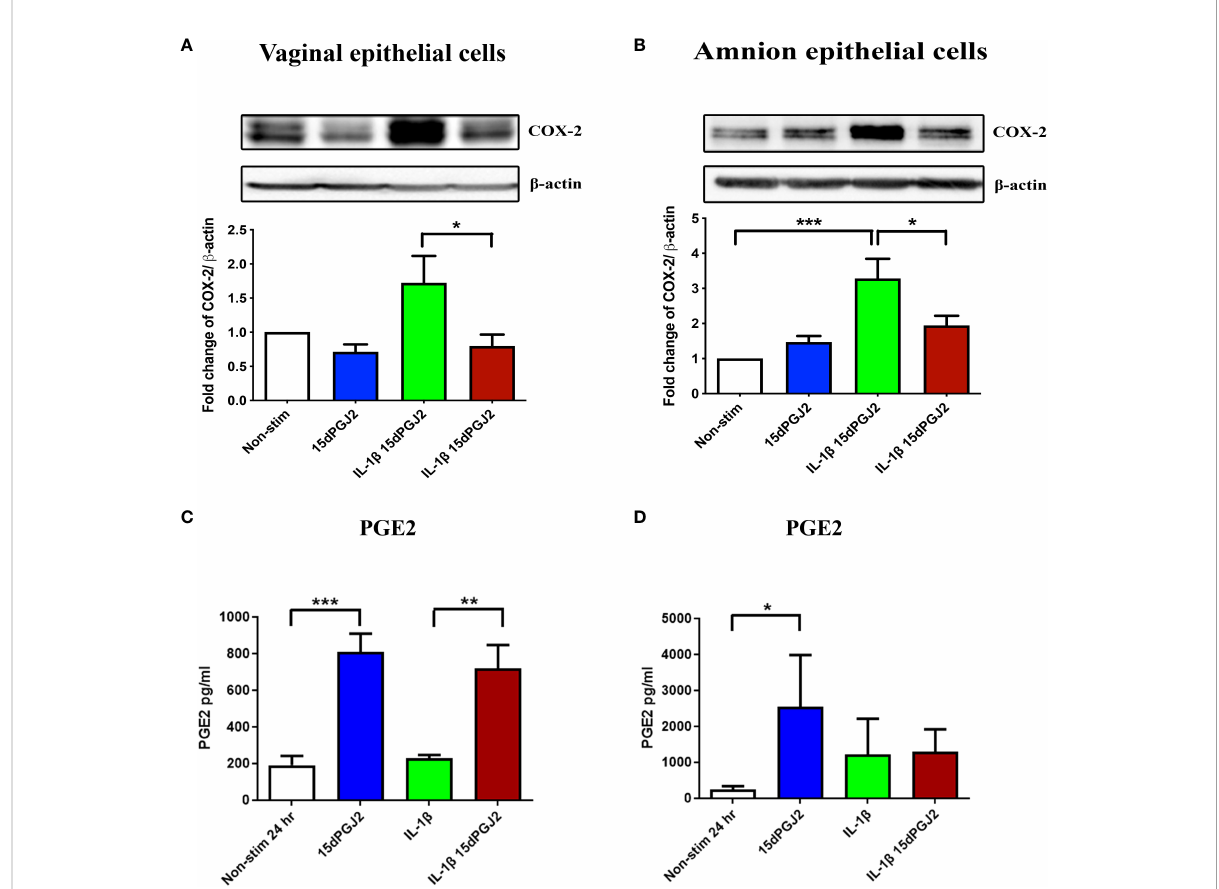
FIGURE 8 Effect of 15dPGJ2 on COX-2 and PGE2 in vaginal and amnion epithelial cells. VECs and AECs were pre-incubated with 32 m M of 15dPGJ2 for 2 hours then stimulated with 1ng/ml of IL-1 b for 4 hours to examine COX-2 protein expression and 24 hours to examine PGE2 production. Whole cell lysate was used to determine COX-2 protein expression and an ELISA was used to determine PGE2 concentration in cell culture supernatant. 15dPGJ2 pre-incubation signi fi cantly inhibited IL-1 b stimulated COX-2 protein expression in VECs ( p < 0.05) (A) and AECs (B) ( p < 0.05) at 4 hours. PGE2 concentration was increased in VEC culture supernatant when treated with 15dPGJ2 ( p < 0.001) and 15dPGJ2 plus IL-1 b ( p < 0.01) (C) and in supernatant of 15dPGJ2 treated AECs ( p < 0.05) (D) . n=3-7. * p < 0.05, ** p < 0.01, *** p < 0.001. Data are presented as mean ±